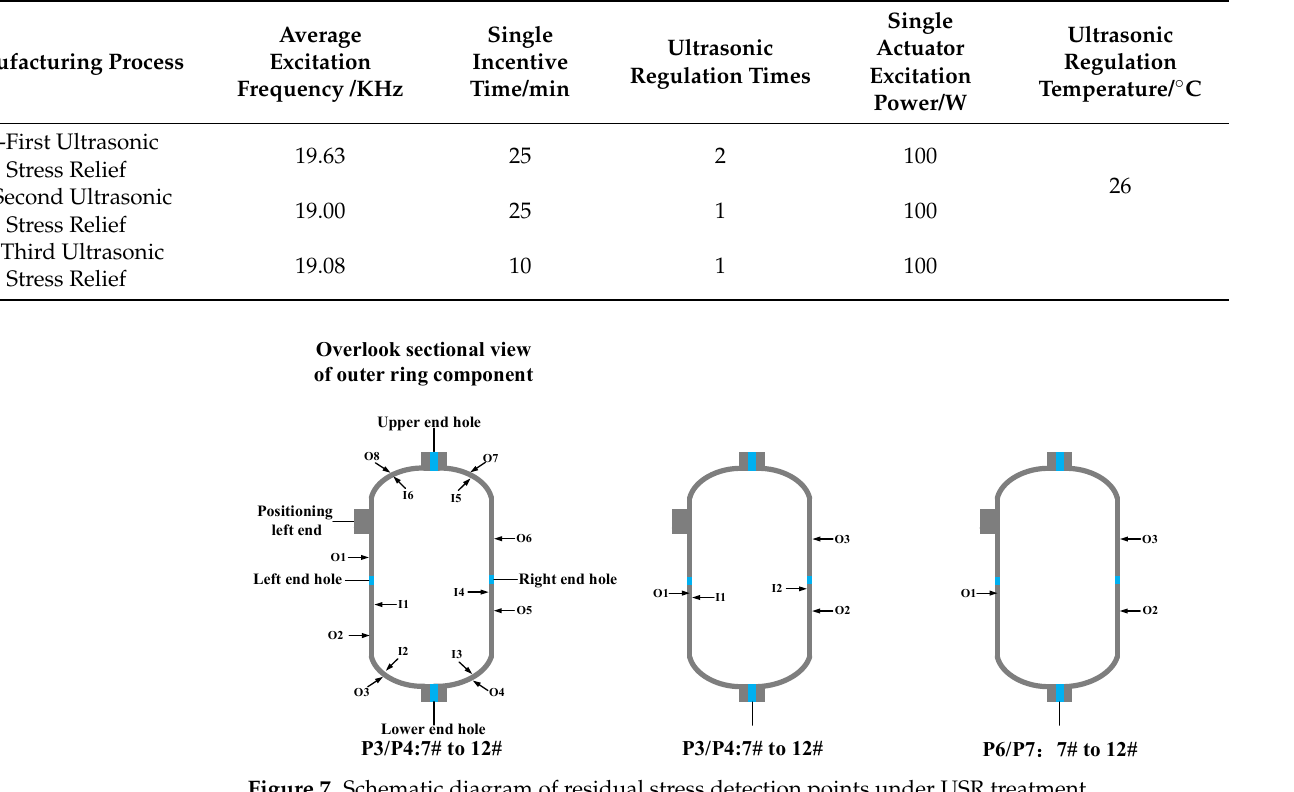
Table 2. Control process parameter.